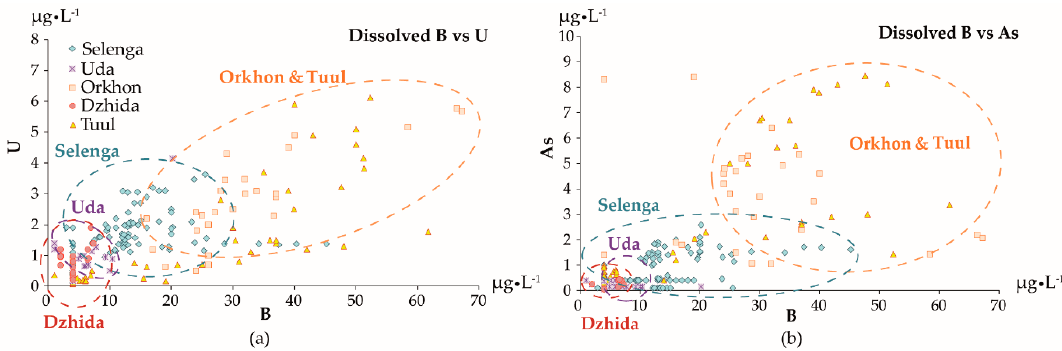
Figure 6. Scatter plot of the correlation between dissolved B and U ( a ), and B and As ( b ), in the main Selenga tributaries.